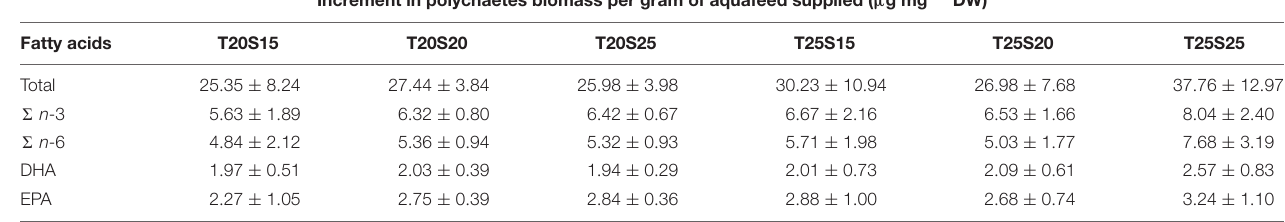
TABLE 4 | Increment in polychaetes biomass ( µ g mg − 1 DW) per gram of aquafeed supplied of total fatty acid, sum of n -3 ( (cid:54) n -3) and n -6 fatty acids ( (cid:54) n -6), docosahexaenoic acid (DHA) and eicosapentaenoic acid